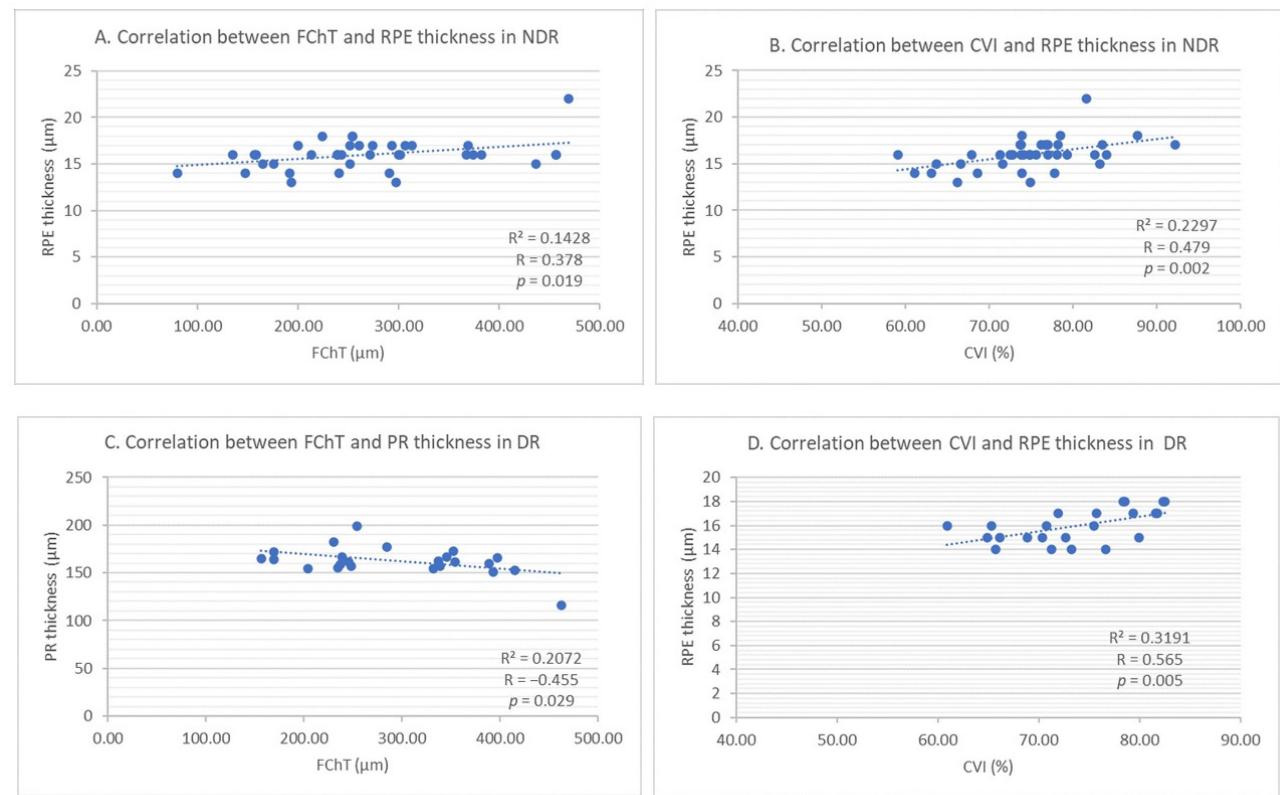
Figure 7. ( A ) Correlation between foveal choroidal thickness and retinal pigment epithelium thickness in NDR. ( B ) Correlation between choroidal vascularity index and retinal pigment epithelium thickness in NDR. ( C ) Correlation between foveal choroidal thickness and photoreceptors’ thickness in DR. ( D ) Correlation between choroidal vascularity index and retinal pigment epithelium thickness in DR.